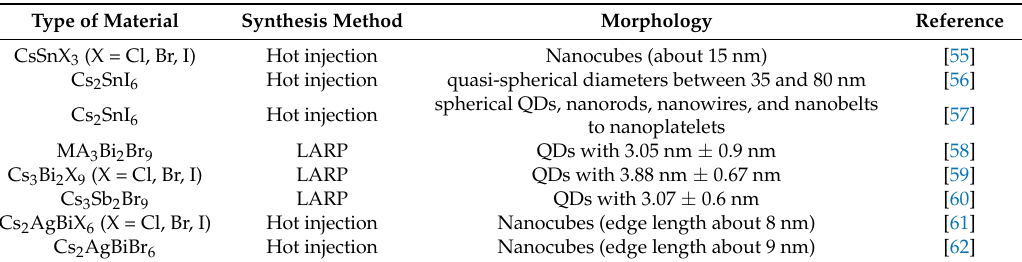
Table 1. Summary of lead-free halide perovskite NCs from